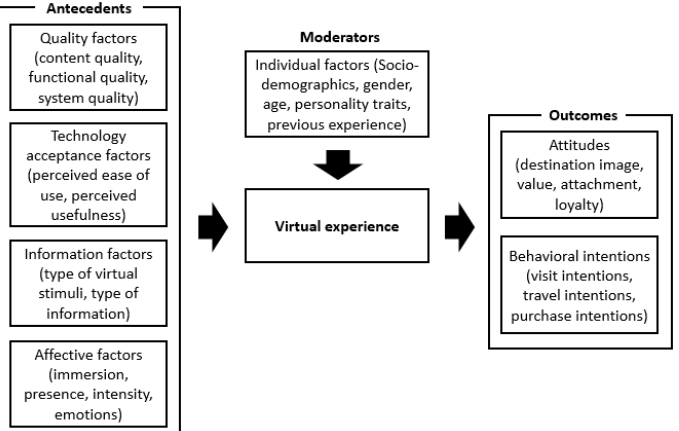
Figure 1. Conceptual